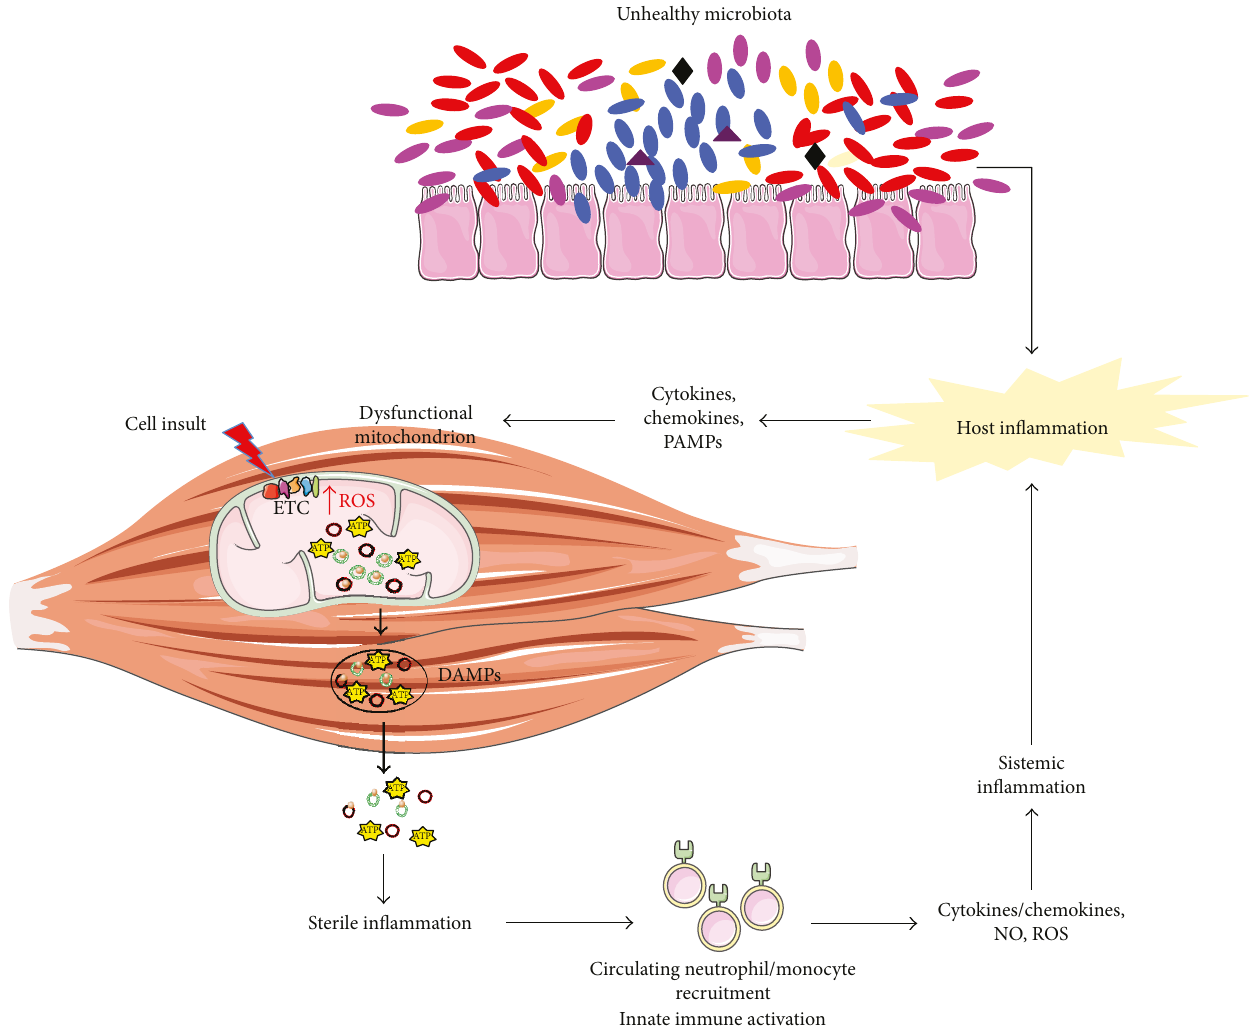
Figure 2: Proposed crosstalk between mitochondrial dysfunction and in fl ammation in muscle wasting. Imbalanced gut microbiota contributes to host in fl ammation and fuels the age-associated impairment of mitochondrial quality control in myocytes. This may lead to the release of mitochondrial damage-associated molecular patterns (DAMPs), such as mtDNA and ATP. The subsequent recruitment of local macrophages may maintain a persistent in fl ammatory milieu by alerting circulating immune cell and mounting a systemic response through the activation of mtDNA-induced in fl ammatory pathways. Cytokines, chemokines, nitric oxide (NO), and reactive oxygen species (ROS), released in the circulation by in fl ammatory cells, can induce further mitochondrial damage, thereby establishing a vicious circle and eventually contributing to muscle wasting. ETC: electron transport chain; mtDNA: mitochondrial DNA; TFAM: mitochondrial transcription factor A; PAMPs: pathogen-associated molecular